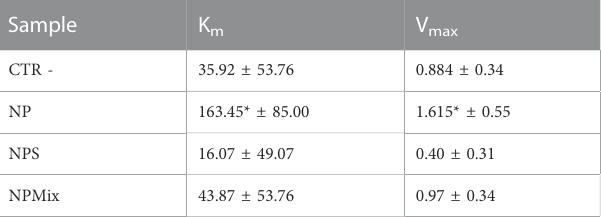
TABLE 4 K m and V max results for the enzyme elastase. Data are reported as mean values ± LSD. * p < 0.001 compared to CTR -.